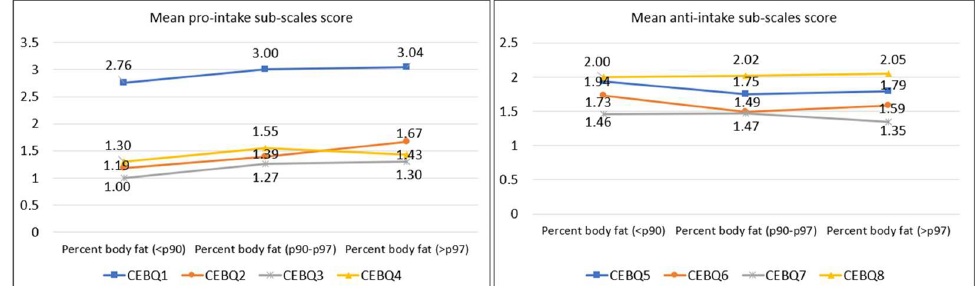
Figure 3. Mean scores of the pro-intake and anti-intake dimensions according to percent body fat (%BF) categories [36]. Contrast of means using the H-Kruskal Wallis test; p -value CEBQ1 = 0.005; p -value CBQ2 = 0.004; p -value CBQ3 = 0.061; p -value CBQ4 = 0.143; p -value CEBQ5 = 0.020; p -value CEBQ6 = 0.014; p -value CEBQ7 = 0.743; p -value CEBQ8 = 0.779.